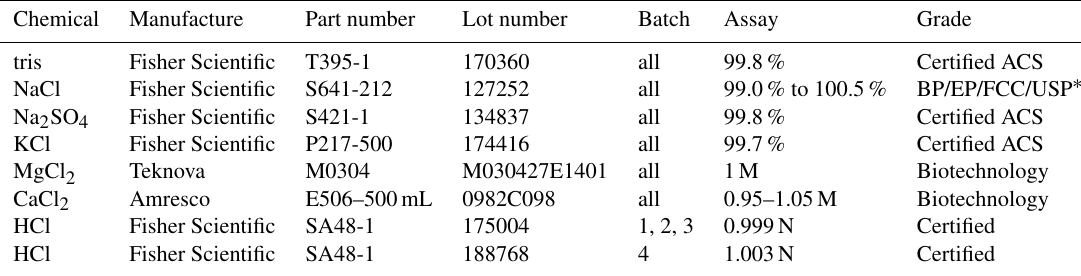
Table A1. Detailed information about the specific reagents used to make the tris solution.